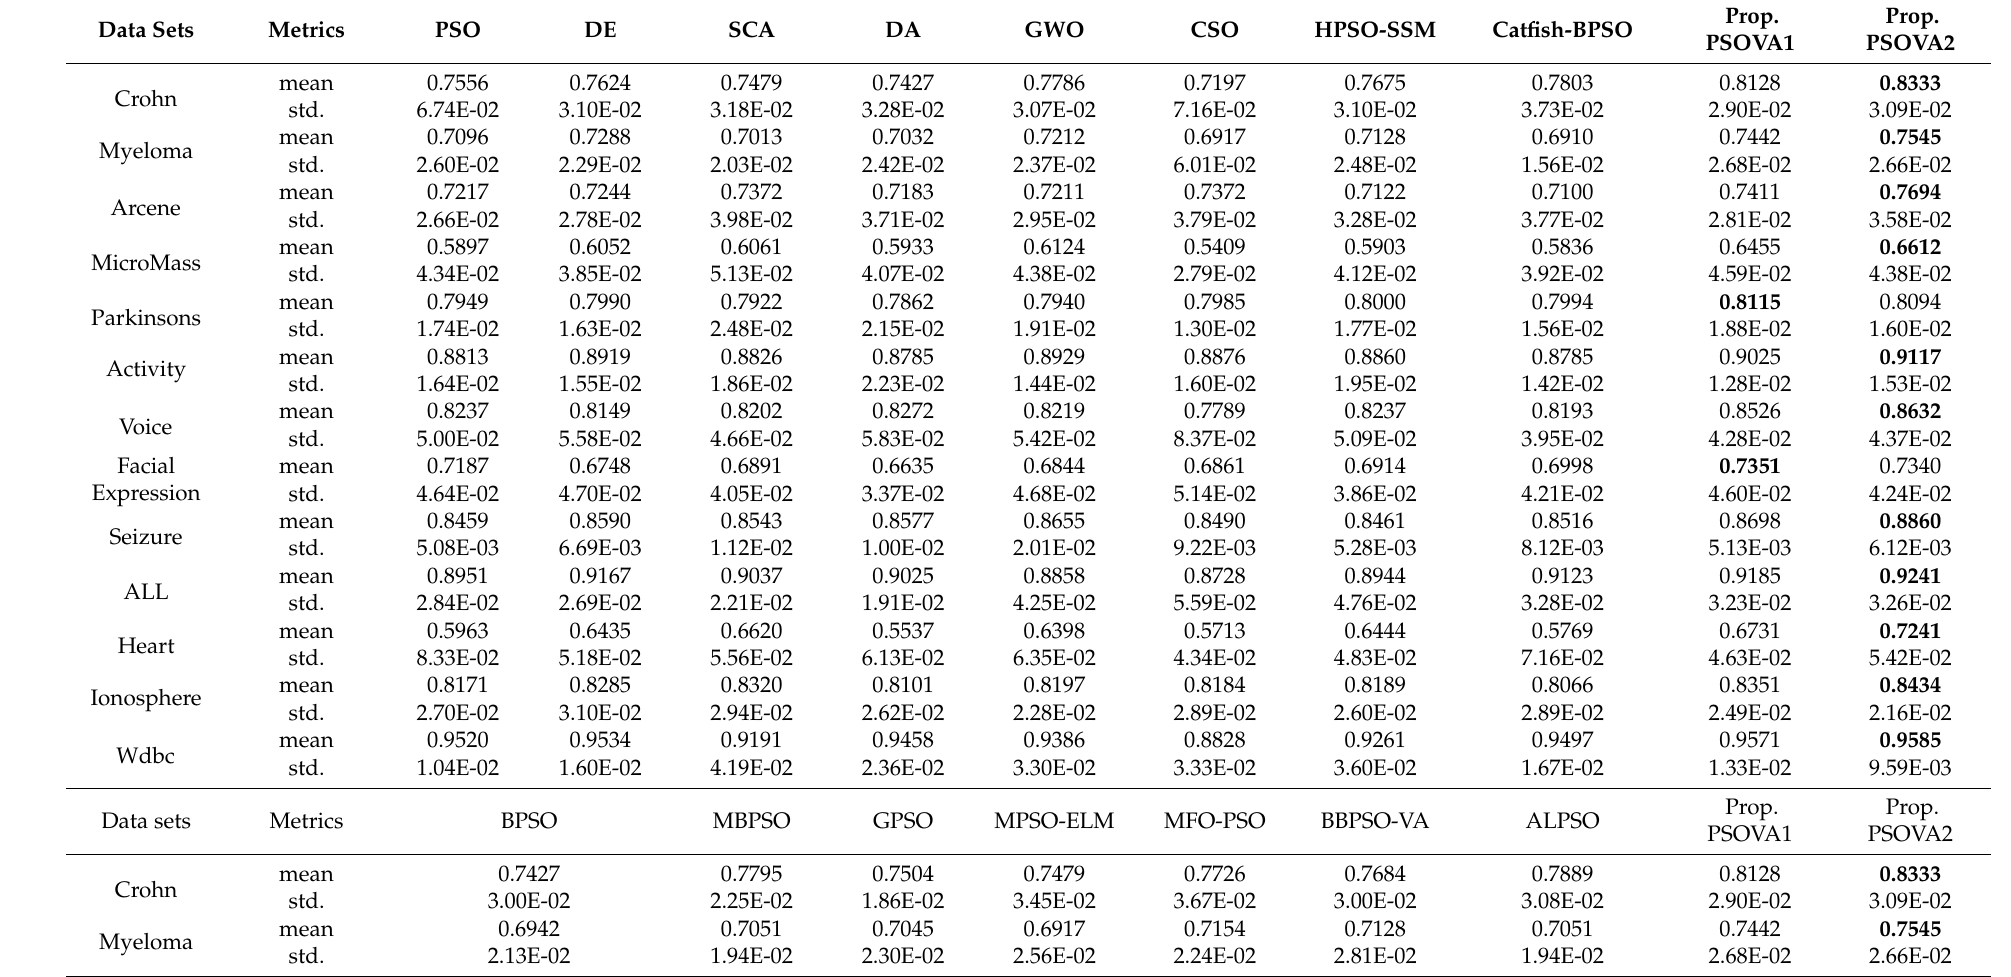
Table 4. The mean results of the classification accuracy rates over 30